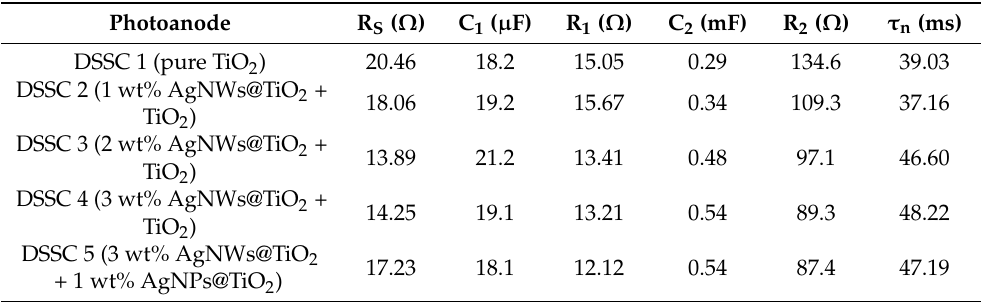
Figure 7. Equivalent circuit and Nyquist plots of the DSSCs with containing different photoanodes. Table 2. Electrochemical impedances spectroscopy (EIS) for DSSCs with different photoanodes.